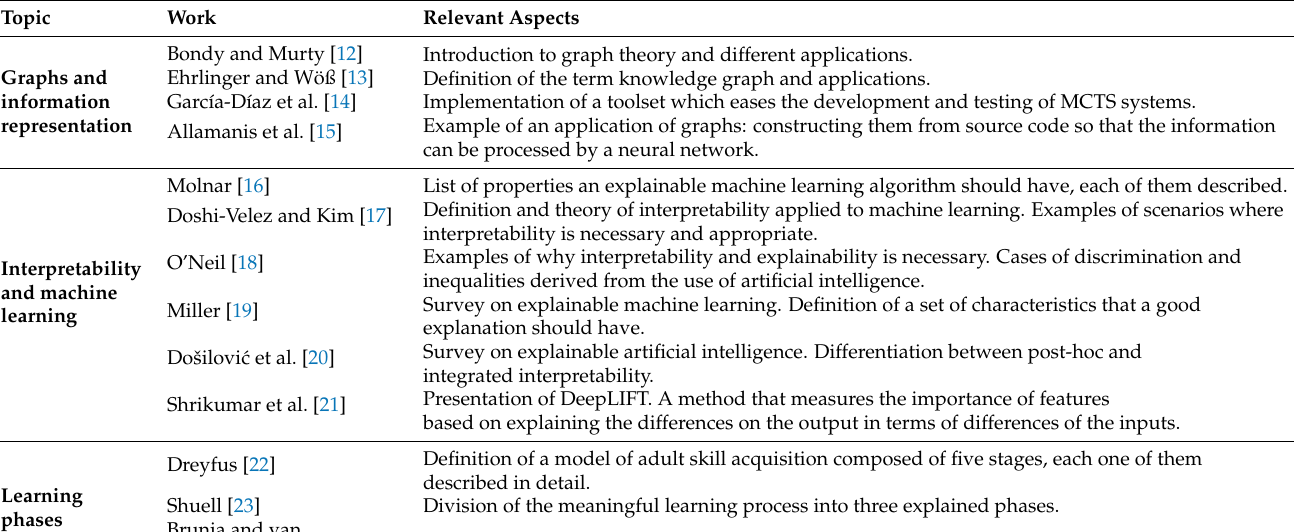
Table 1. Main related works grouped by topic and their most relevant aspects for our